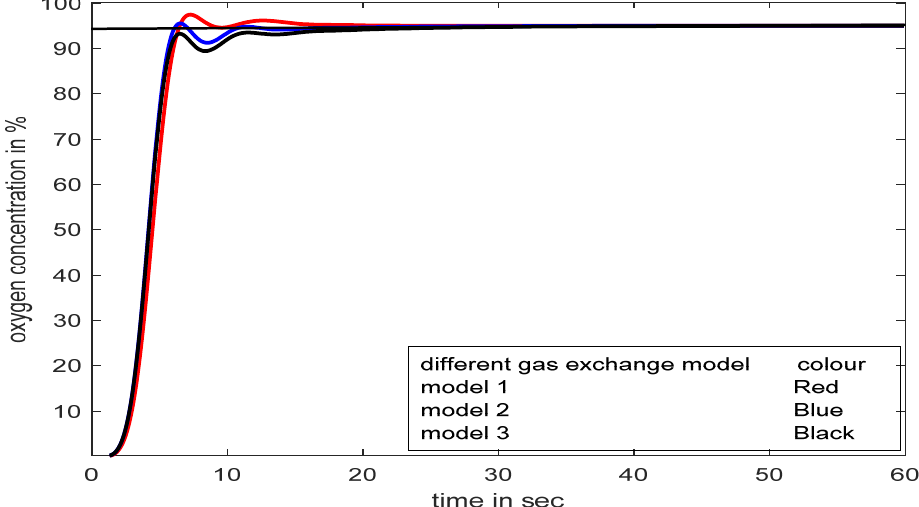
Figure 18 . Process responses with SFPIMRAC for model parameters variations.